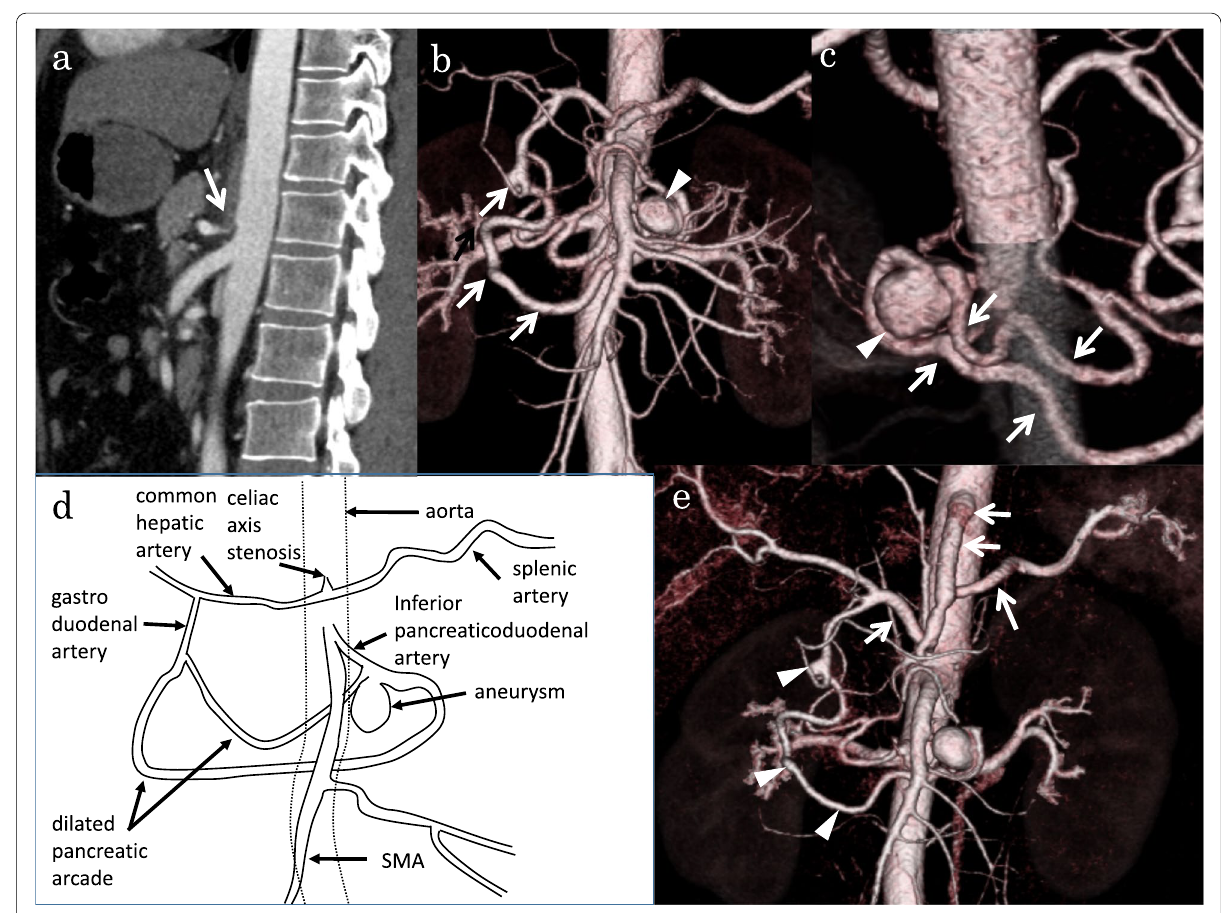
Fig. 5 Images from Case 2. a Computed tomogram (sagittal plane) showing severe stenosis of the celiac axis (white arrow). b , c Three-dimensional computed tomogram showing markedly dilated pancreatic arcade (white arrows) with a large saccular pancreaticoduodenal artery aneurysm (white arrowheads). d The schematic diagram of Case 2. e Three-dimensional computed tomogram obtained 2 days after bypass surgery showing excellent flow of the hepatic and splenic arteries via bypass (white arrows) and decreased thickness of the pancreatic arcade (white